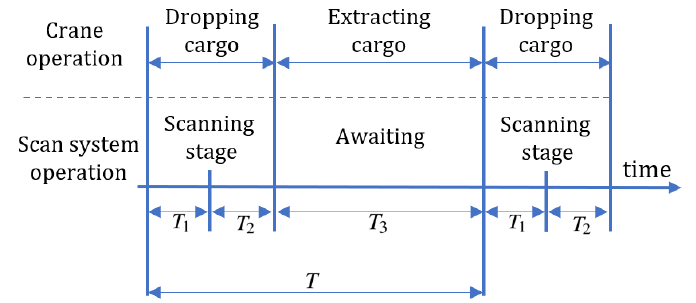
Figure 2. Two cycles of the crane operation with time